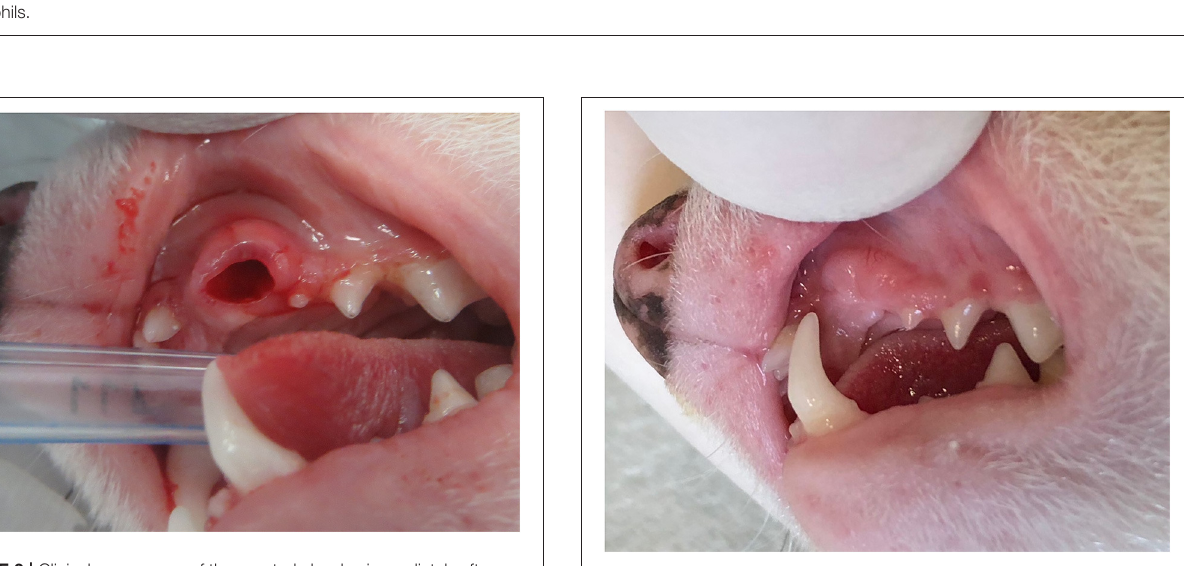
FIGURE 3 | Clinical appearance of the vacated alveolus immediately after simple (closed) extraction of the periodontally healthy fractured left maxillary canine tooth.